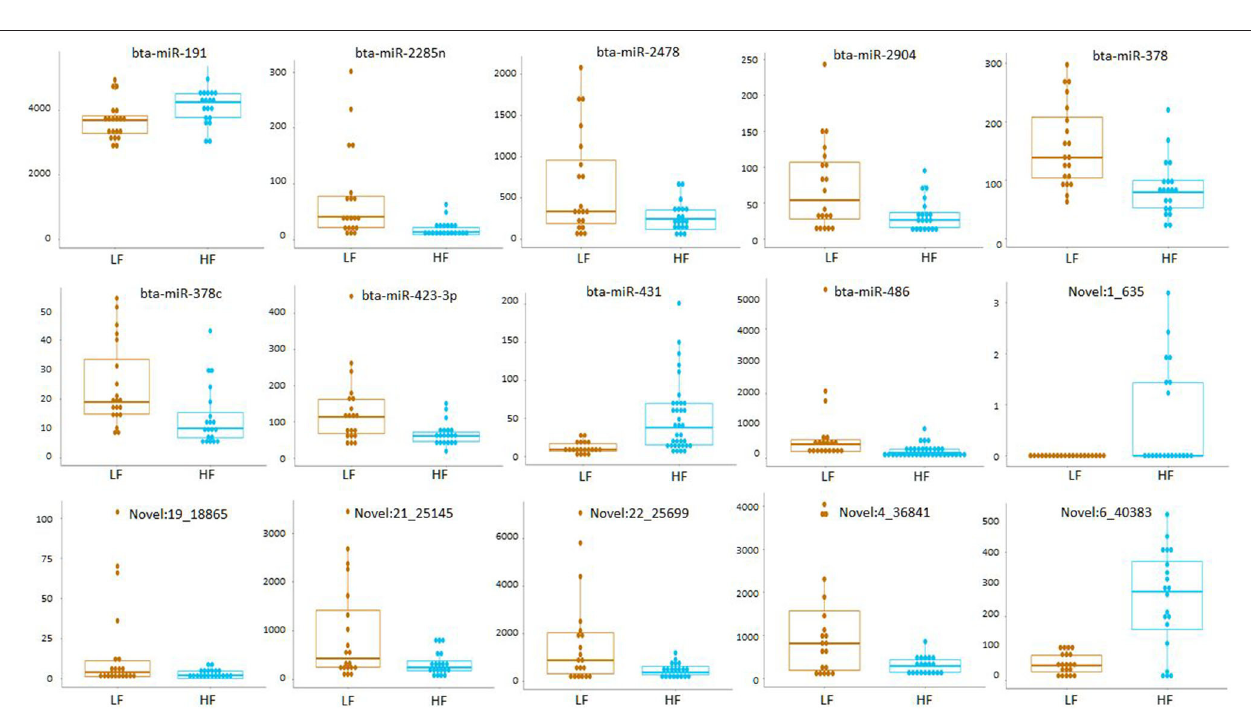
FIGURE 3 | Read count of DE-miRNAs between HF and LF